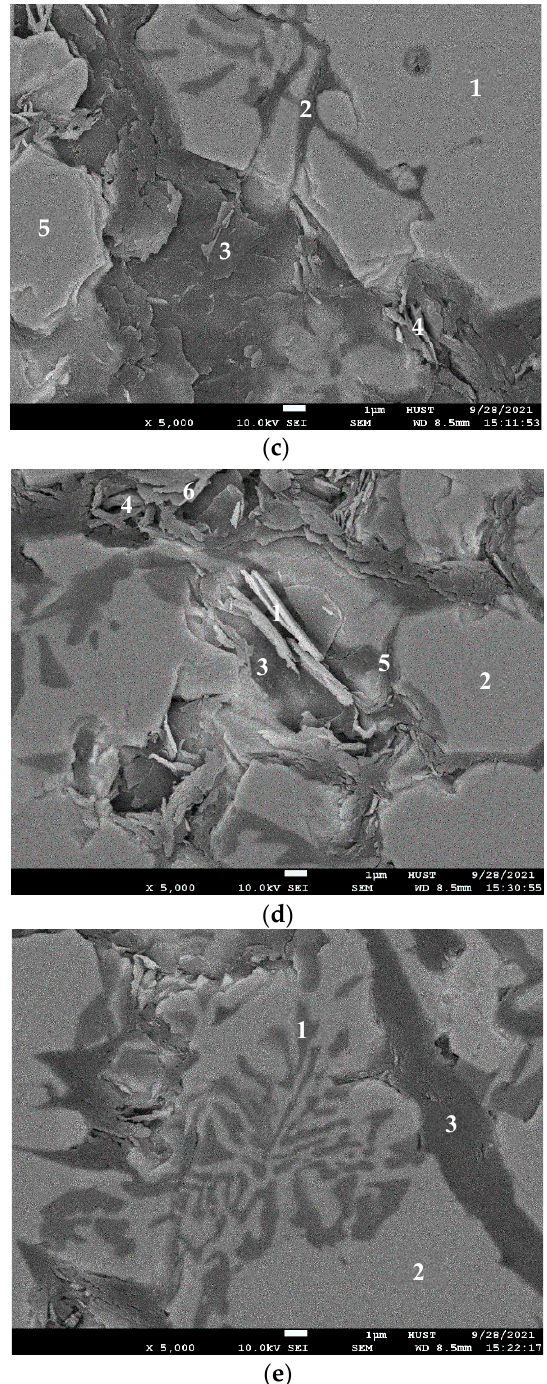
Figure 4. SEM image of cross section of laser cladding coating. ( a ) Whole SEM image of the coating; ( b ) Locally amplified SEM image at area A in ( a ); ( c ) Locally amplified SEM image at area A1 in ( b ); ( d ) Locally amplified SEM image at area B1 in ( b ); ( e ) Locally amplified SEM image at area C1 in ( b ). A, A1, B1, C1 represent different regions in the coating, while 1,2,3,4,5,6 represent different position points. Table 2. EDS results of five positions in Figure 4c.